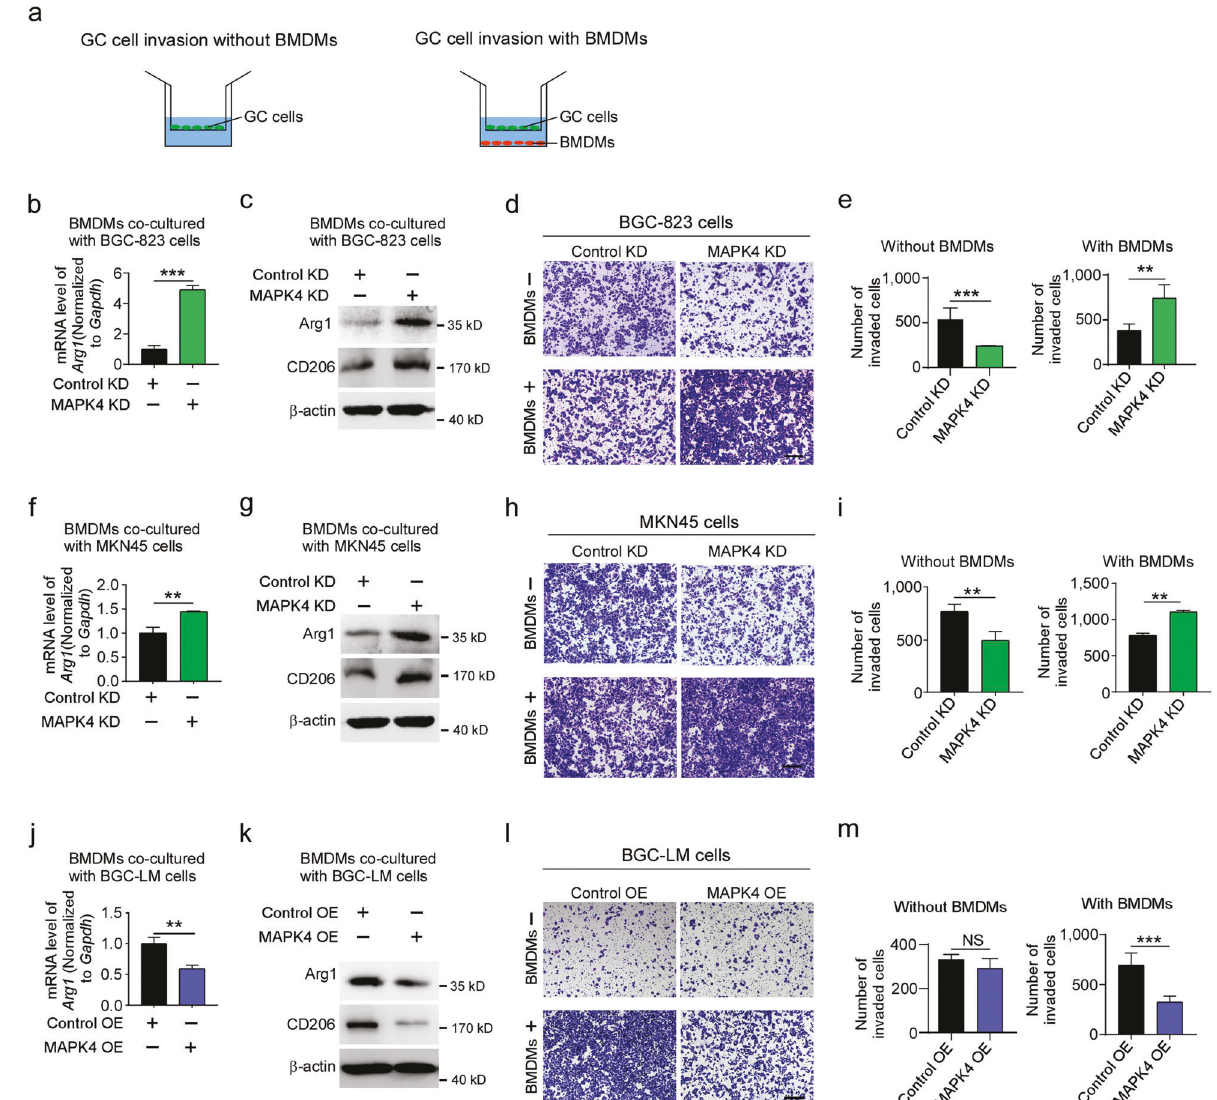
Fig. 4 MAPK4 downregulation promotes TAM polarization and cancer cell invasion in a coculture system. a Schematic of the coculture of gastric cancer cells with or without BMDMs in the Boyden chamber system. The upper chamber was coated with Matrigel. b , c Quantitative RT-PCR analysis of Arg1 mRNA and western blot analysis of Arg1 and CD206 proteins in BMDMs cocultured with control and MAPK4-depleted BGC-823 cells. d , e Control and MAPK4-depleted BGC-823 cells cocultured or not cocultured with BMDMs were subjected to cell invasion analysis. The quanti fi cation of invaded cells per well is shown. f , g Quantitative RT ‒ PCR analysis of Arg1 mRNA and western blot analysis of Arg1 and CD206 proteins in BMDMs cocultured with control and MAPK4-depleted MKN45 cells. h , i Control and MAPK4-depleted MKN45 cells cocultured or not cocultured with BMDMs was subjected to cell invasion analysis. The number of invaded cells per well was quanti fi ed. j , k Quantitative RT-PCR analysis of Arg1 mRNA and western blot analysis of Arg1 and CD206 proteins in BMDMs cocultured with control and MAPK4-overexpressing BGC-LM cells. l , m MAPK4-overexpressing BGC-LM cells cocultured or not cocultured with BMDMs were used for the cell invasion assay. The number of invaded cells per well was quanti fi ed. Scale bar, 200 μ m. The data are expressed as the means ± standard deviations. ** p < 0.01, *** p < 0.001; NS not signi fi cant (Student ’ s t